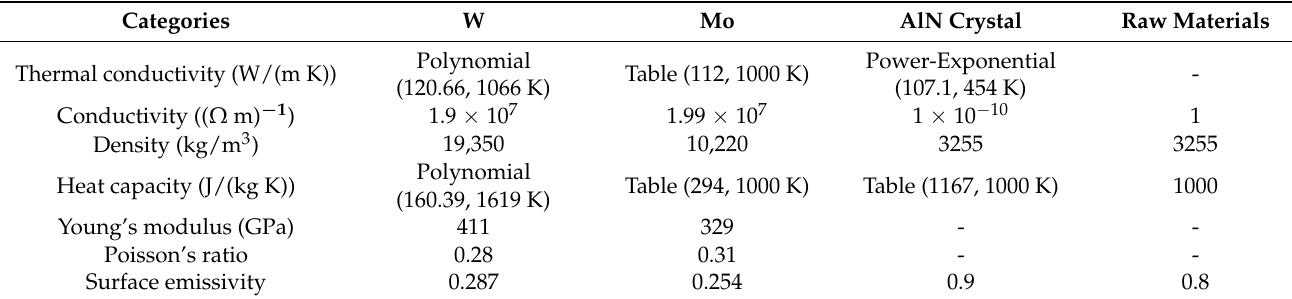
Table 3. Physical parameter of different materials.